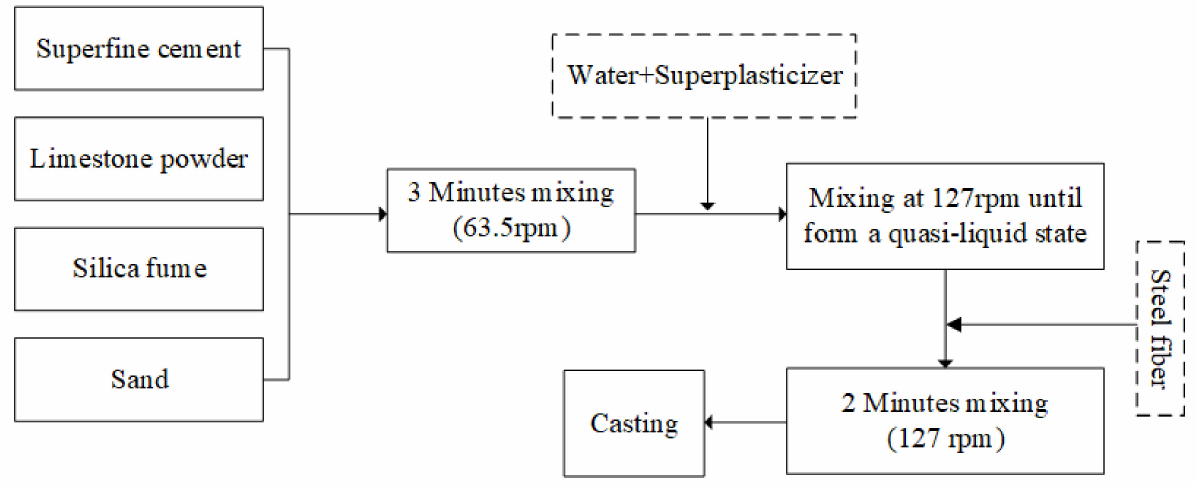
Figure 3. The mixing procedure to prepare reverse filling cementitious